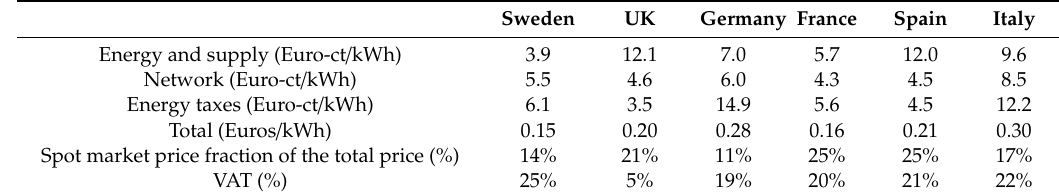
Table 7. Breakdown of residential electricity average price for the year 2015 for the examined locations and for customers with the relevant annual demand (Band DD).